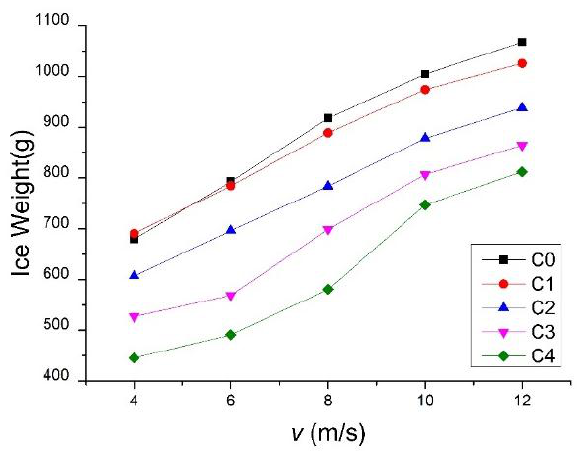
Figure 4. Ice mass of blade samples under Conditions 1–5.